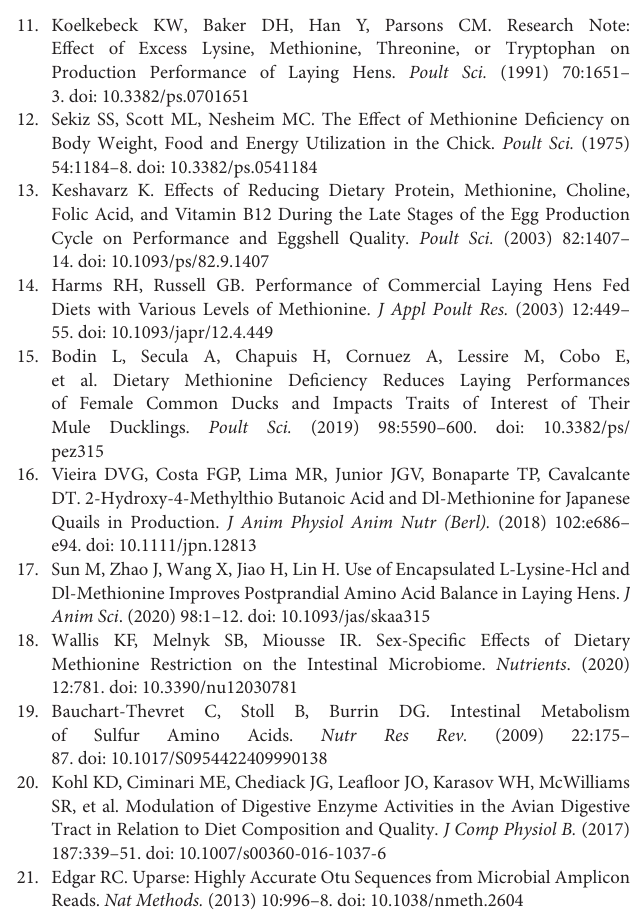
Supplementary Figure 1 | Effects of Met deficiency in rearing period diets on the alpha diversity of the gut microbiota in egg-laying chicks at 6 weeks. (A) Sobs index of the community diversity. (B) Chao index of the community richness. (C) Shannon index of the community diversity. (D) Ace index of the community